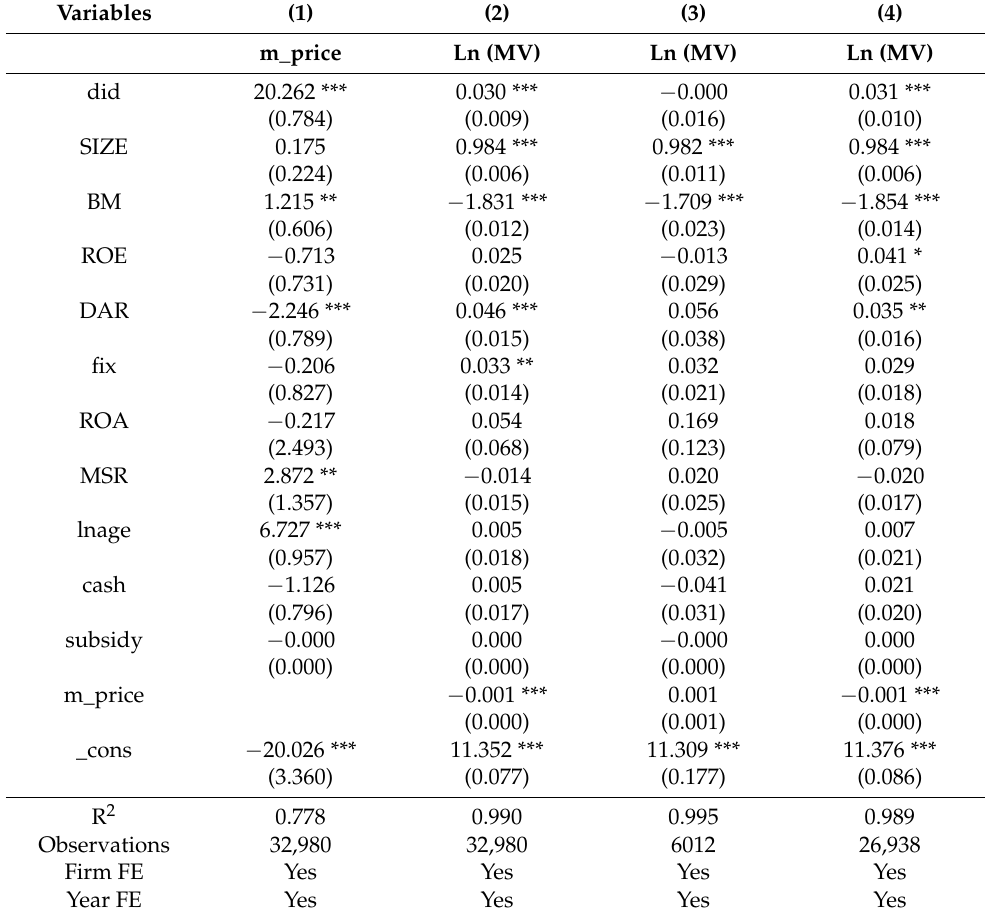
Table 6. Regression results of mediation mechanism analysis based on carbon